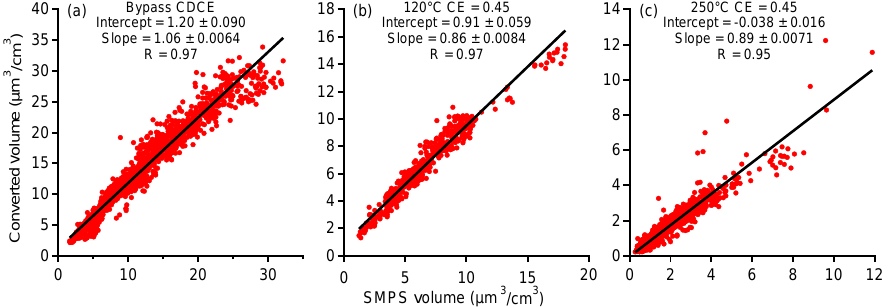
Figure 2. Scatter plot of converted volume (based on HR-ToF-AMS total + BC + crustal material) vs. the apparent volume estimated from SMPS measurement for (a) the bypass line and the TD line at (b) 120 ◦ C and (c) 250 ◦ C. The composition-dependent CE is applied to the bypass line HR-ToF-AMS measurements and CE = 0.45 is applied to the TD line HR-ToF-AMS measurements. The slopes and intercepts are obtained by orthogonal distance regression (ODR). The Pearson’s R is obtained by linear least-squares fit.